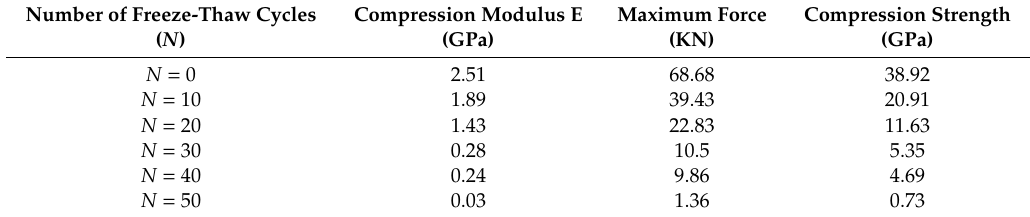
Table 1. Strength values of specimens after different freeze–thaw cycles.